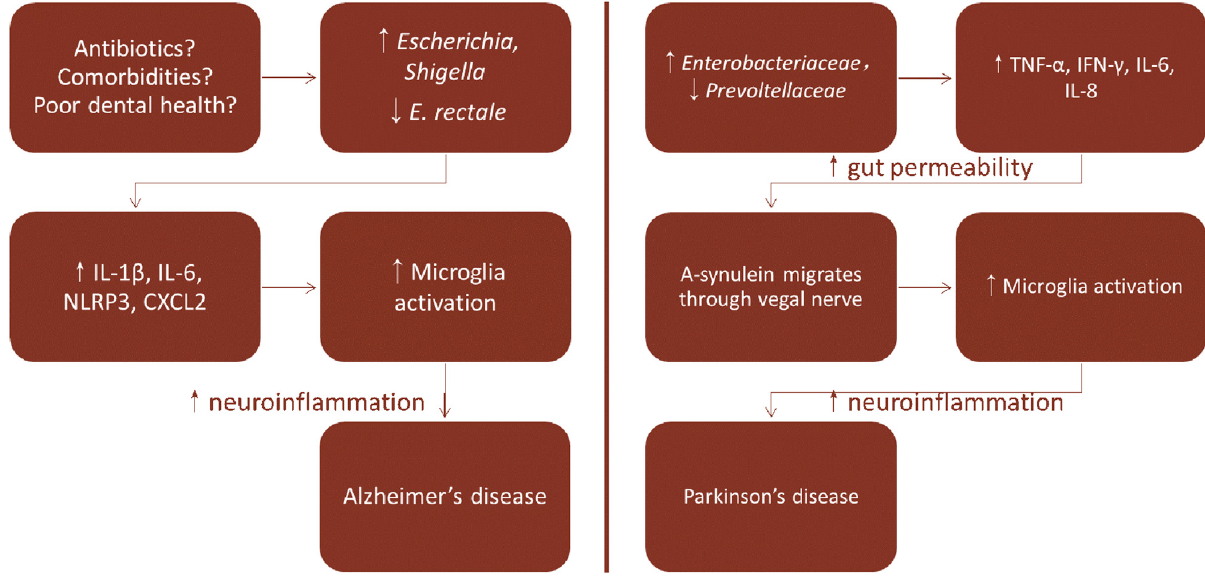
Figure 2: Possible pathogenic mechanism of PD and AD due to gut microbiota imbalance [ 5 ]